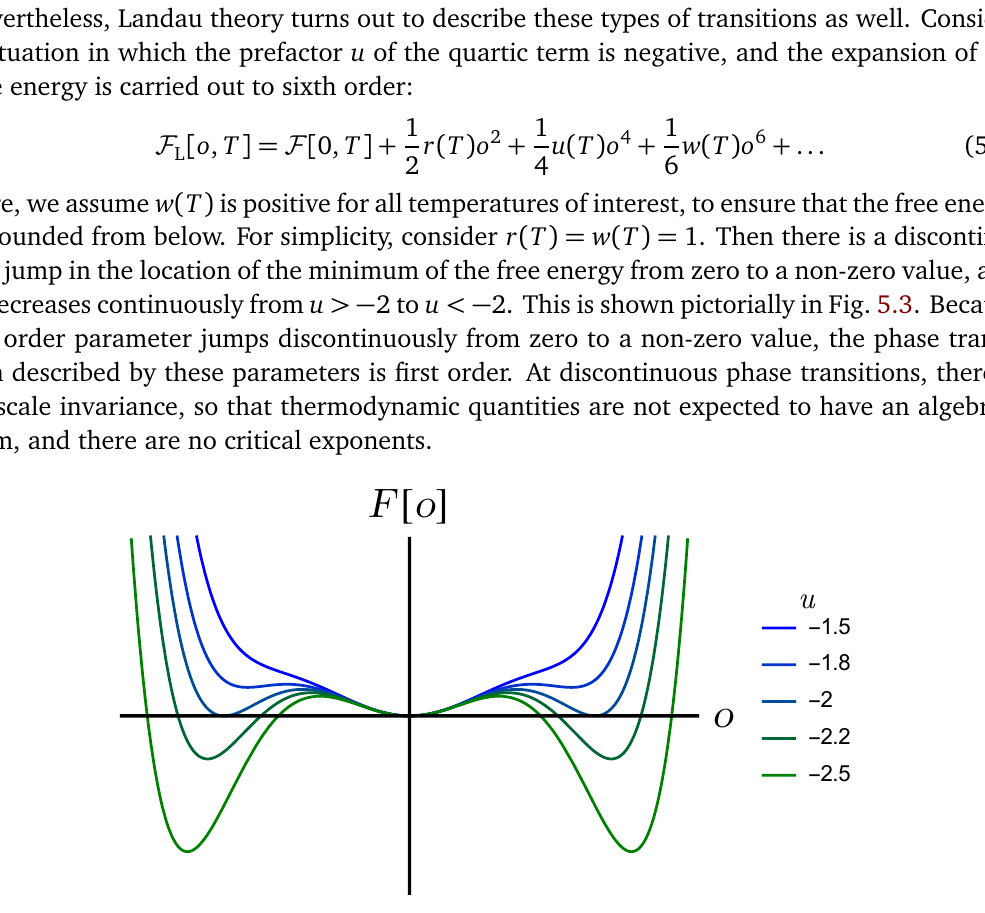
jumps from zero to non-zero values L